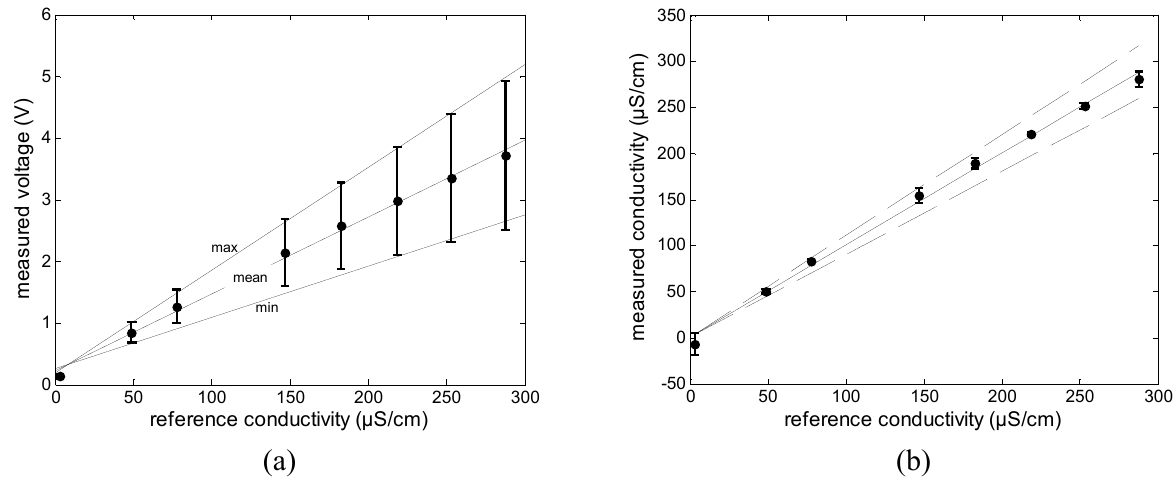
Figure 3 . (a) Measured voltage in dependence of the electrical conductivity. The three solid lines represent the linear fits for mean, maximal and minimal values within a same reference conductivity value. (b) Comparison of the measured κ from (1) after correction with reference values. The dashed lines represent the 10% deviation from the ideal line (solid line). In both plots the errors bars denote the maximal deviation from mean values (full circles). The horizontal error bars associated with the reference measurements (0.5%) are too small to be